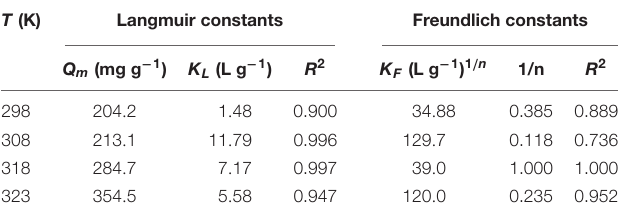
TABLE 2 | Isotherm constants and values of R 2 for TiO 2 /Ti.